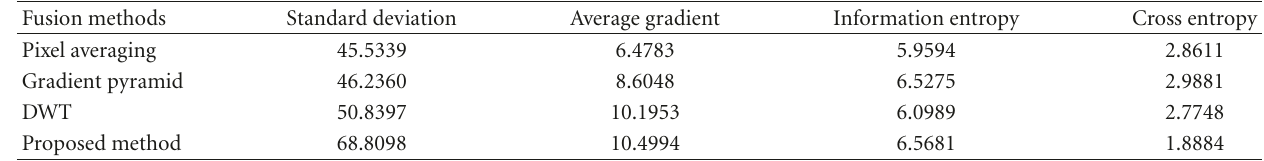
Table 2: Quantitative evaluation results of the four di ff erent fusion methods in Figure